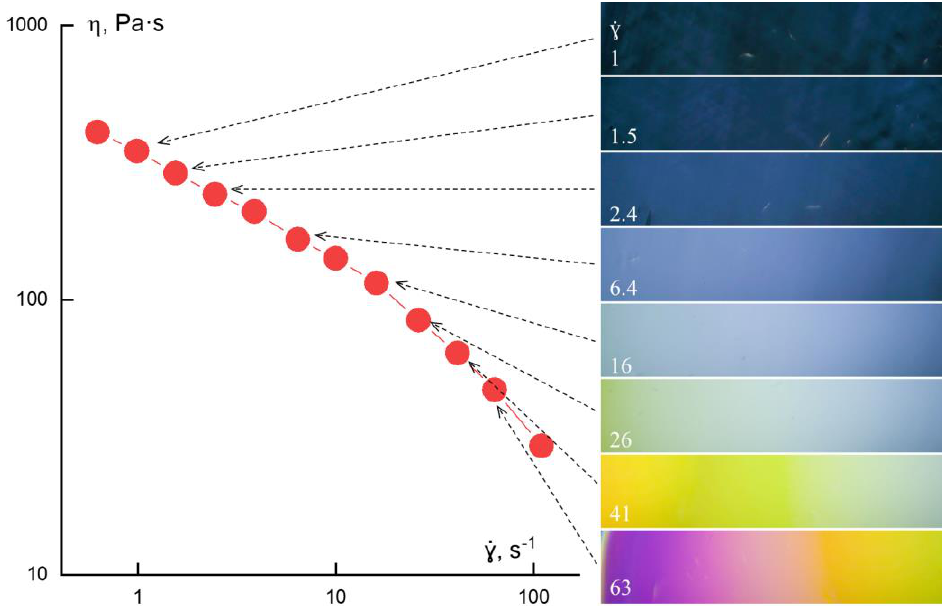
Figure 29. The flow curve of 5.7% solution of PABI in DMAc and the birefringence intensity corre- sponding to different shear rates (unpublished data presented by courtesy of Dr. Ivan Skvortsov).